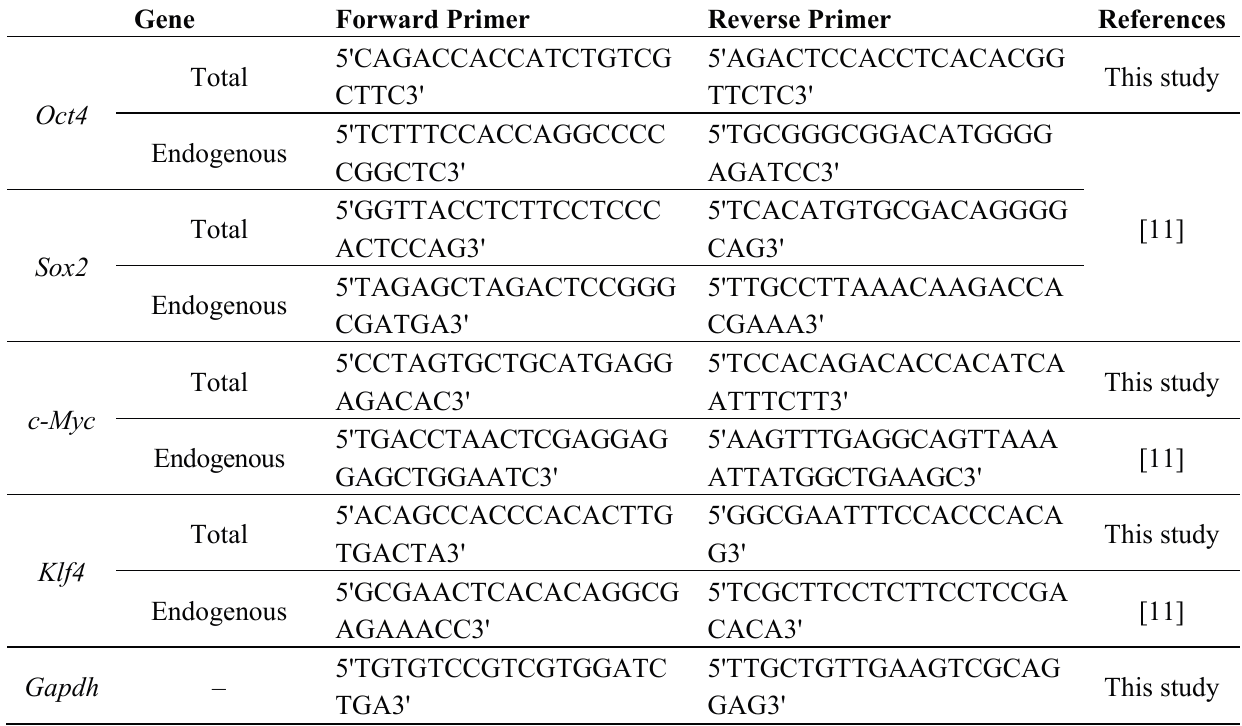
Table 2. Primers used for quantitative real time PCR